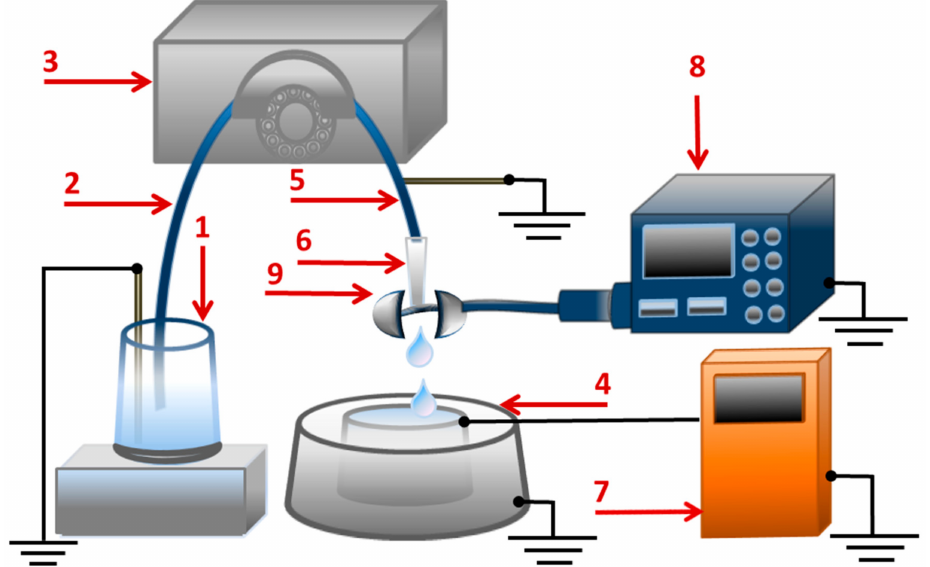
Figure 1. Experimental setup. (1) Tube with the analyzed liquid; (2) silicone pipe (incoming section); (3) peristaltic pump; (4) measuring cell coupled with electrometer (7); (5) silicone tube (outgoing section); (6) tip; (7) electrometer; (8) pulse generator; (9) parallel metal